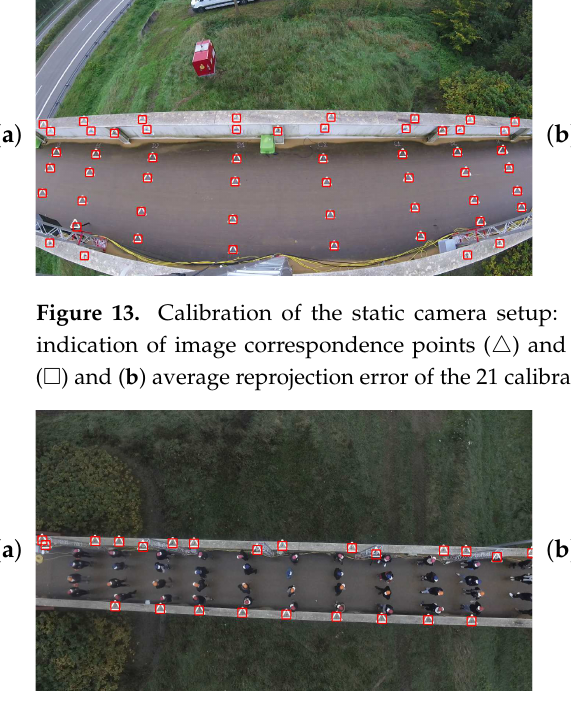
Figure 14. Calibration of the drone camera: ( a ) initial frame with indication of image correspondence points ( ) and the reprojected world correspondence points ( (cid:3) ) and ( b ) indication of the drone’s initial (cid:52) position relative to the bridge deck (red dot) and initial FOV (gray-shaded